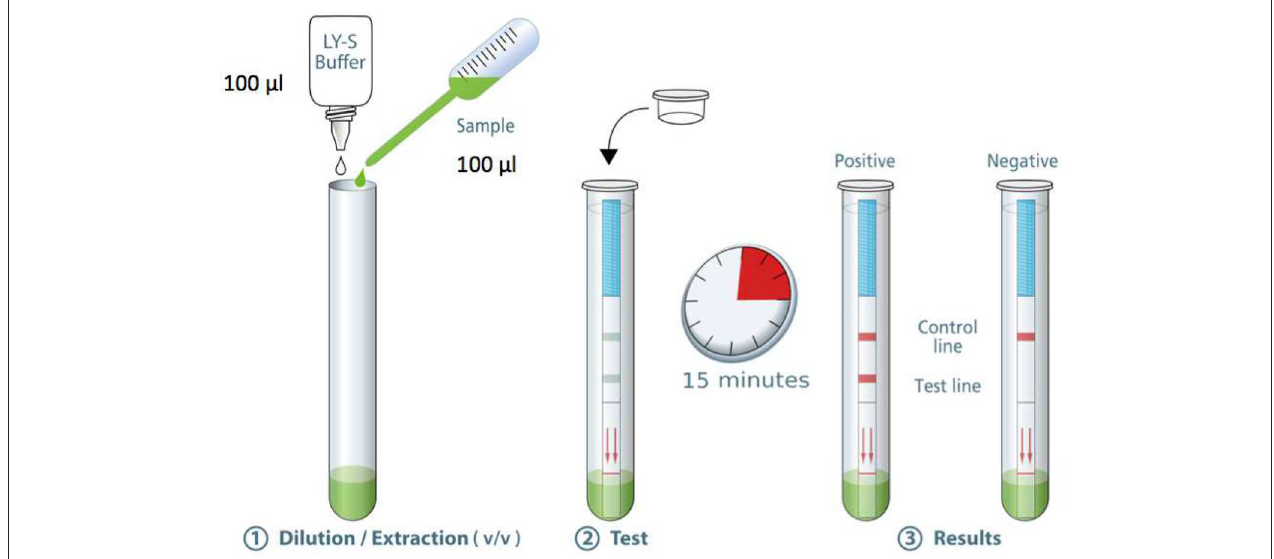
FIGURE 1 | Standard operating procedure SARS-CoV-2 Respi-Strip ® from Coris